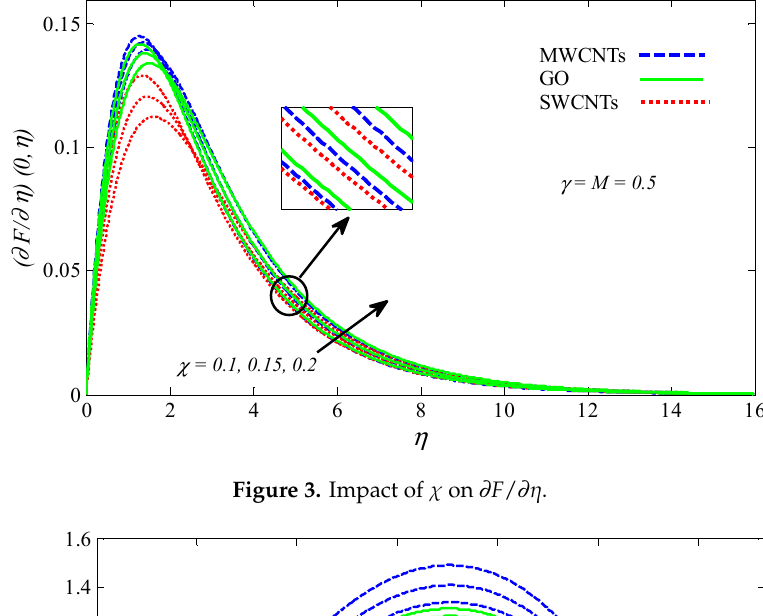
Figure 3. Impact of χ on ∂ F / ∂η .